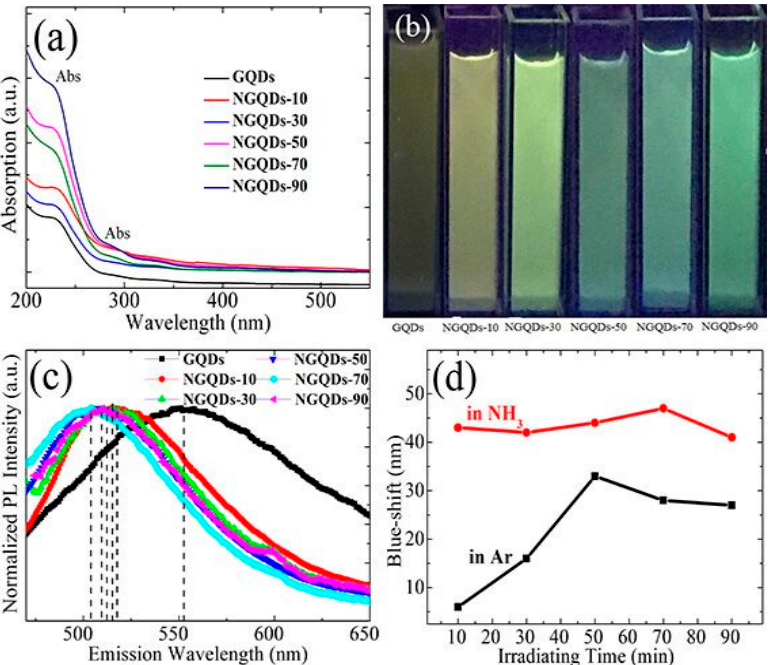
Figure 4. ( a ) UV-vis absorption spectra of the GQDs and NGQDs; ( b ) Optical photograph of the GQD and NGQD samples under irradiation from a UV lamp with a wavelength of 365 nm; ( c ) Normalized photoluminescence (PL) spectra of the GQD and NGQD samples excited at 400 nm; ( d ) The dependence of the PL blue-shift of the NGQDs and rGQDs compared to the GQDs on irradiating time.